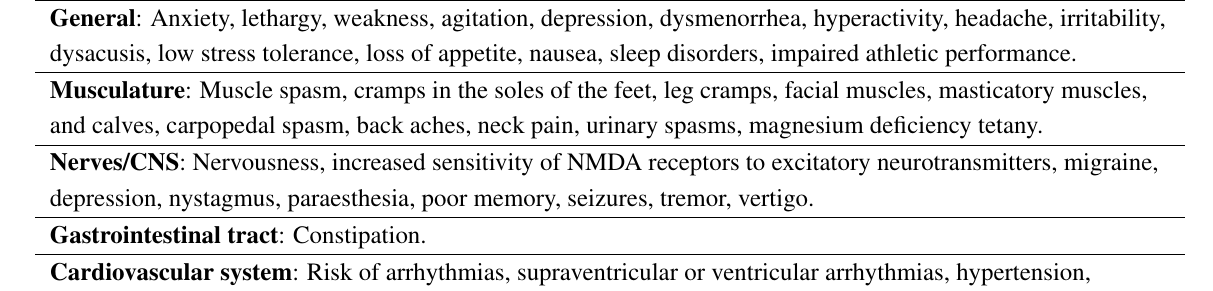
Table 2. Magnesium: Deficiency signs and symptoms [7].